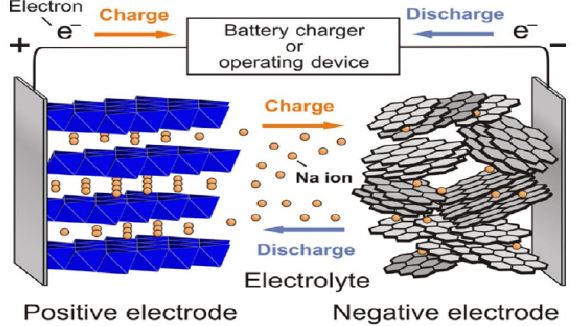
Figure 2. Schematic diagram of the working principle for sodium ion battery [8]. Copyright 2011,